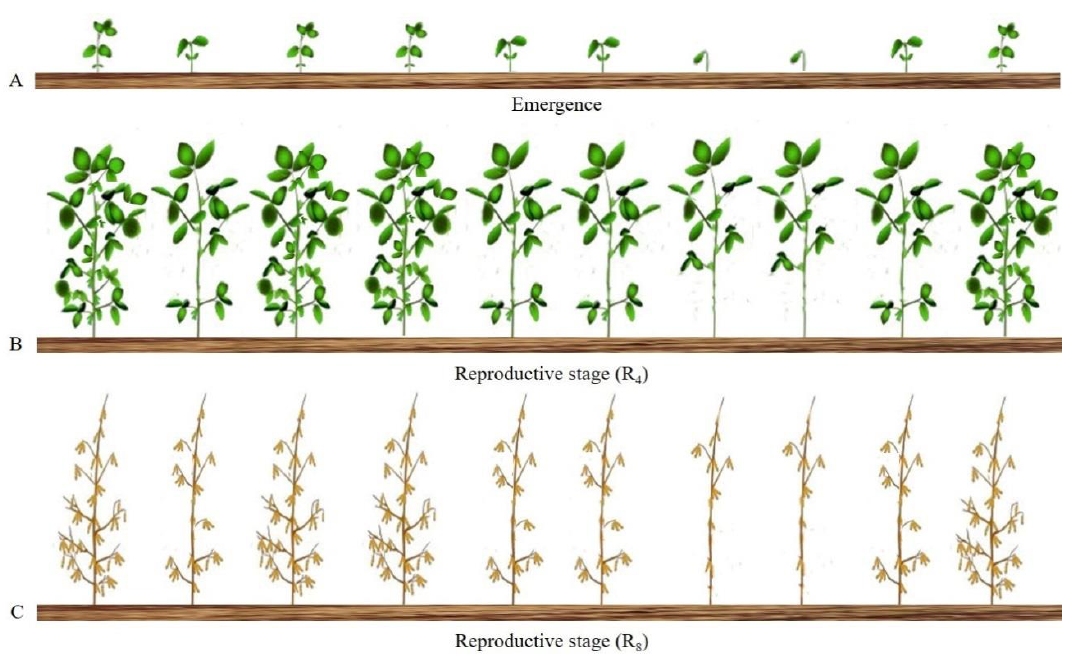
Figure 5. Schematic representation of nonuniformity e ff ect of the plants emergence through crop cycle. ( A ) Plant growth nonuniformity due to di ff erent days of plant emergence. ( B ) Plants in the reproductive stage (R 4 ) with medium and slow emergence are equal in height with plants of early development, but have smaller leaf area and number of nodes. ( C ) Plants in physiological maturity (R 8 ) that emerged first have higher yields due to the higher number of nodes and fertile pods when compared to medium and slow emergence